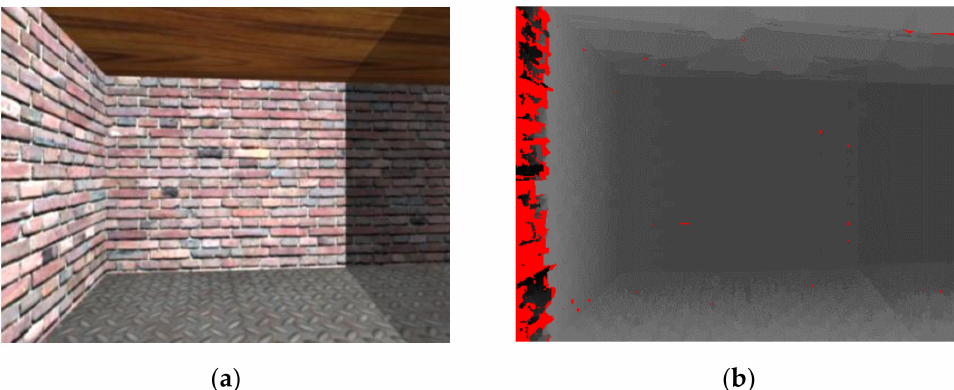
Figure 4. Disparity error detection for the left view using disparity variation: ( a ) Left raw image; and ( b ) red points for the disparity image are regarded as